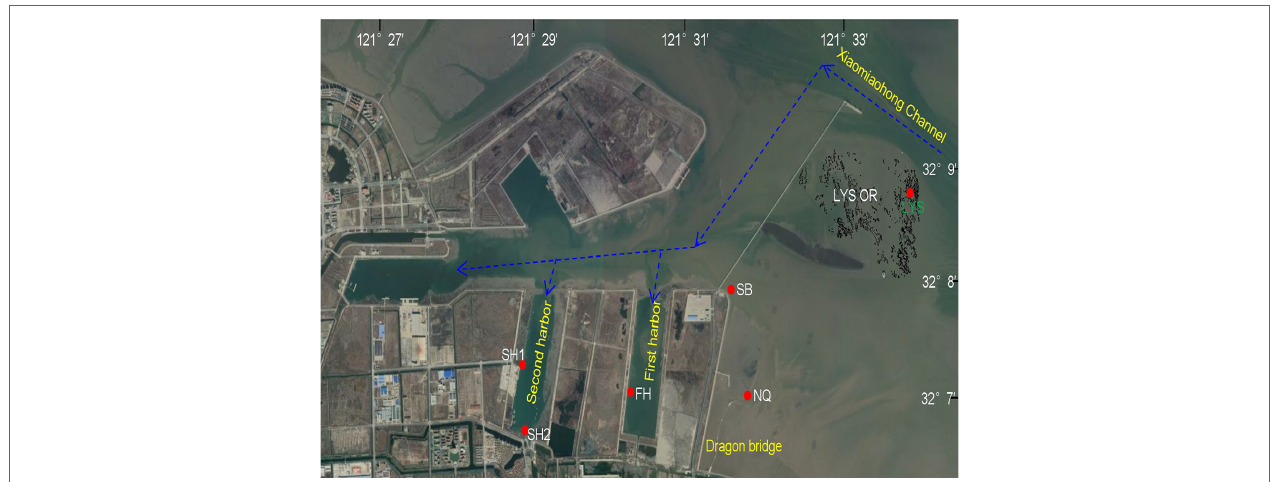
FIGURE 1 | The Liyashan oyster reef (LYS OR) and five no-reef monitoring stations (red circle) for oyster and barnacle recruitment. The arrows indicate the direction of the flooding tide